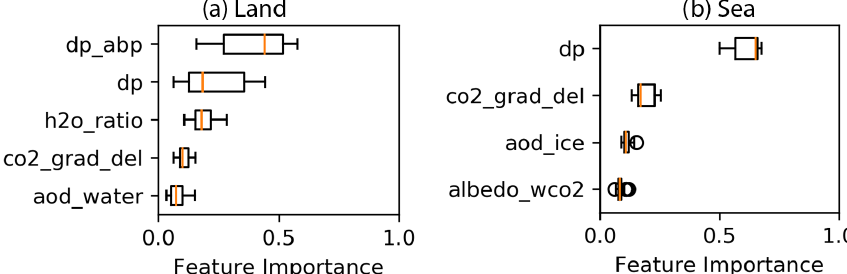
Figure 8. Feature importance for the bias correction model. Feature importance is shown for land (a) and sea (b) observations. The model was trained using the training set with QF = 0 and QF = 1 data. Please refer to Sect. 3.4 for a description of the individual